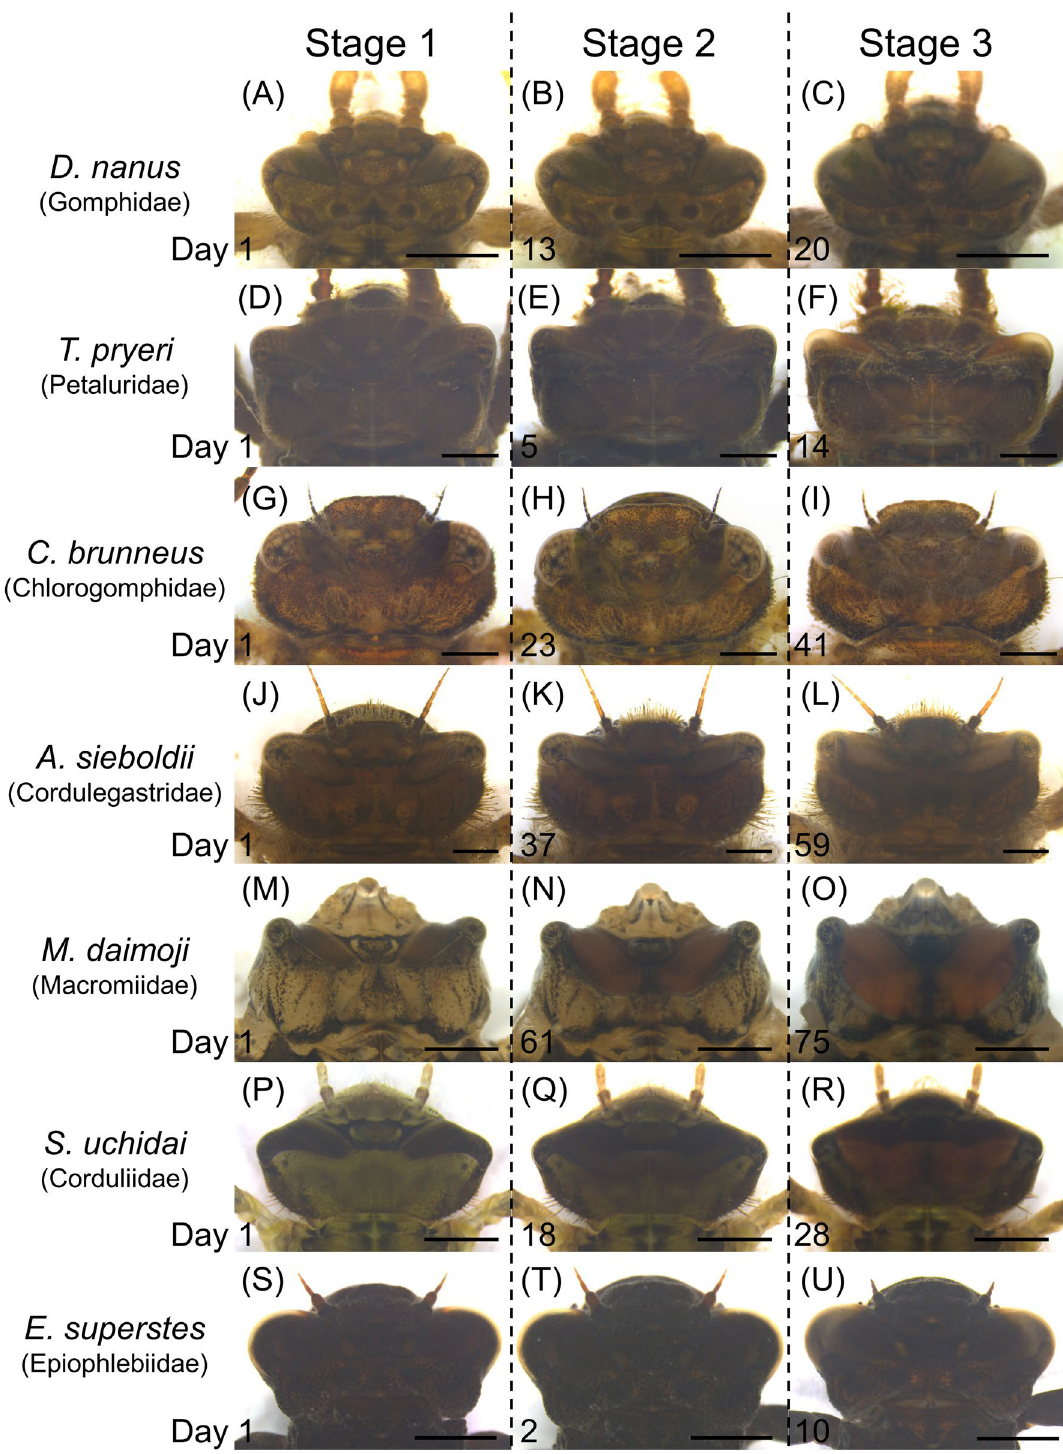
Figure 6. Morphological changes of the compound eyes during F−0 instar in Gomphidae, Petaluridae, Chlorogomphidae, Cordulegastridae, Macromiidae, Corduliidae, and Epiophlebiidae species. ( A – U ) Dorsal views of the heads. All scale bars show 2 mm. Species and family names are provided on the left side. The number shown on the lower left of each image indicates the number of days from the day of ecdysis or collection. ( A , D , G , J , M , S ) The first day of starting photographing. ( P ) The first day of stage 1. ( B , E , H , K , N , Q , T ) The first day of stage 2. ( C , F , I , L , O , R ) The first day of stage 3. ( U ) The day before adult